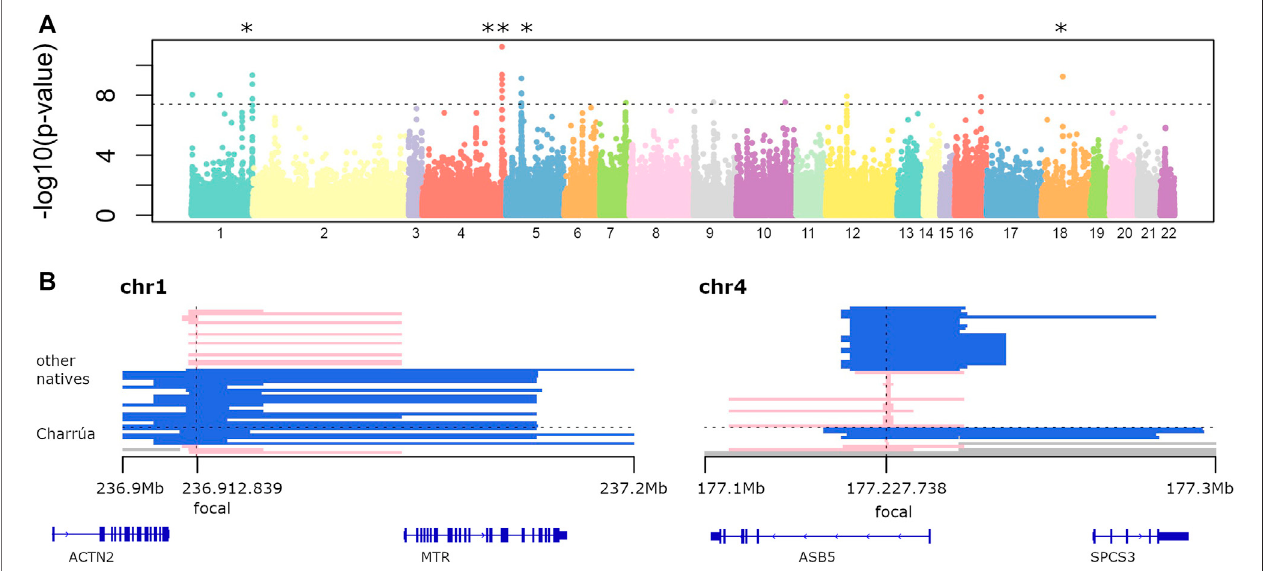
FIGURE2| Selectionsignatures (A) − log10ofp-valueofgenome-wide iHSanalysis.Dotsabovethelinecorrespondtosigni fi cantp-values( − log10(p-values) > 7). Several regions are found to be signi fi cant. The top fi ve were marked with the asterisk. (B) Two examples of signi fi cant haplotypes according to iHS. To the left, is the region in chromosome 1. Blue haplotypes are conserved among 6 out of 10 Uruguayan haplotypes, and its extension is shown with the bars (ranging from 236.9 to 237.2 Mb).Fourindividualshaveadifferentshorthaplotype(inpink).Totheright,ahighlyconservedbluehaplotypeinchromosome4amongUruguayans(4outof 9), which is broken in other Amerindians (shorter blue bars). Missing data is represented in gray, corresponding to masked haplotypes. Also, genes falling within those regions are shown